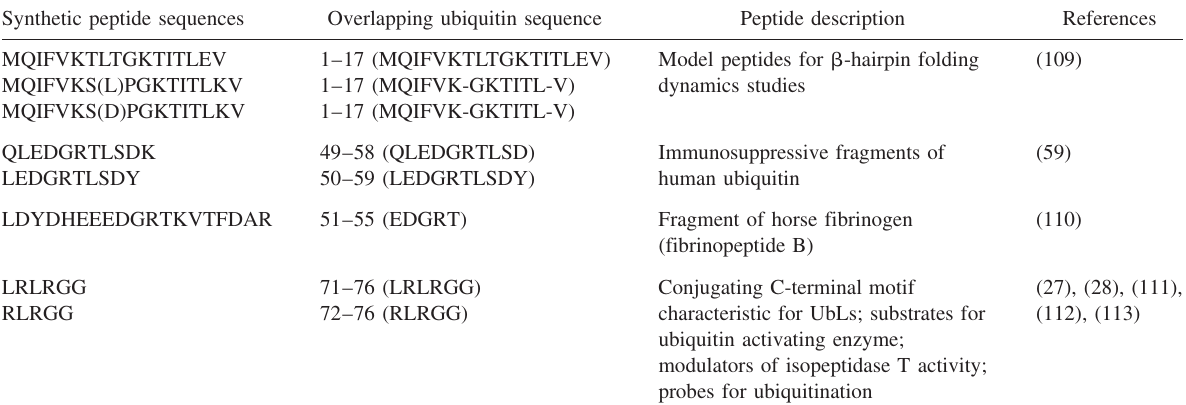
Table 2 The list of synthetic peptides studied to date containing Ub-derived pentapeptide sequences. Synthetic peptide